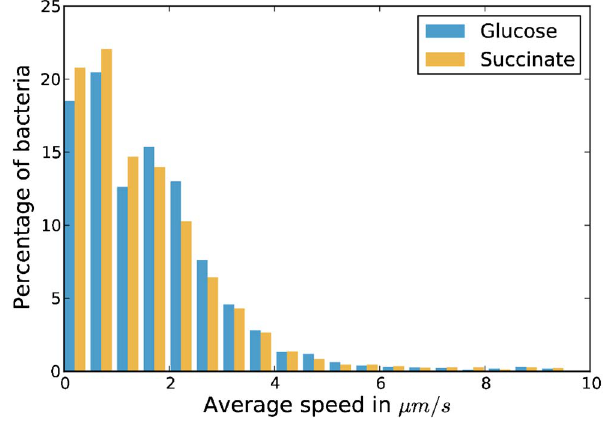
Figure 1. Histogram of average swimming velocities of D. shibae . The velocities are given in m m/s and the heights of the bars indicate the fraction of bacteria displaying this velocity.